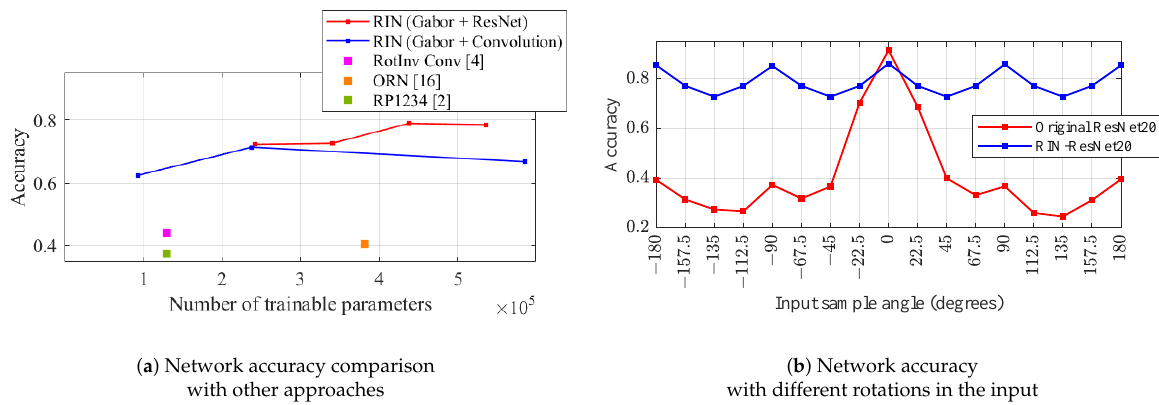
Figure 6. Accuracy values forthe proposed architecture on CIFAR-10 (training: up-right/validation: rotated). Table 2. Obtained error rate CIFAR-10 dataset (training: up-right/validation: